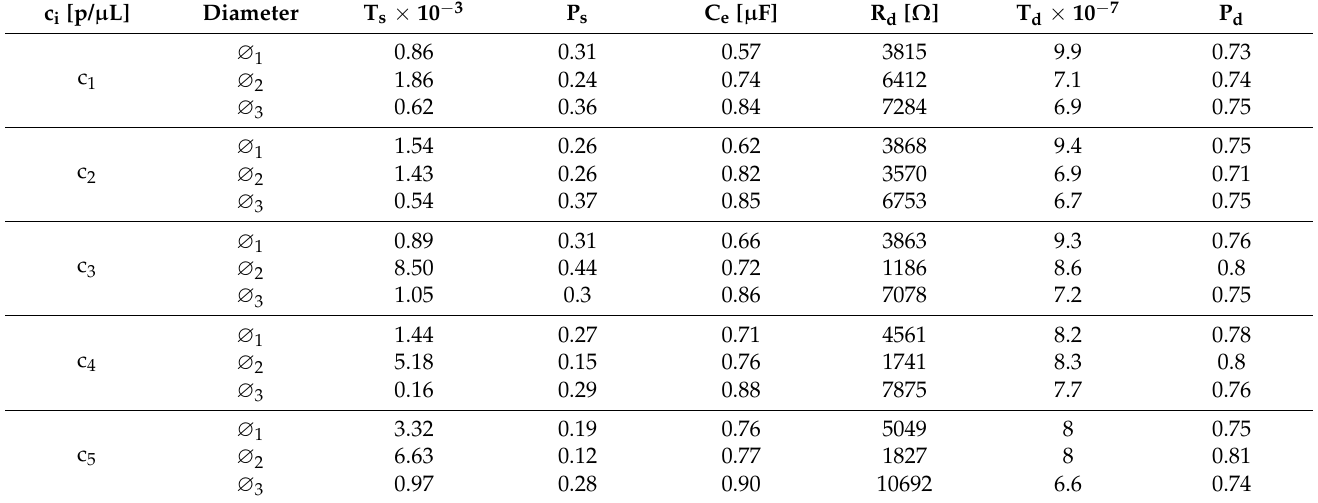
Table 2. Fitting results with the proposed electrical circuit (Figure 2) using the Levenberg–Marquardt optimization